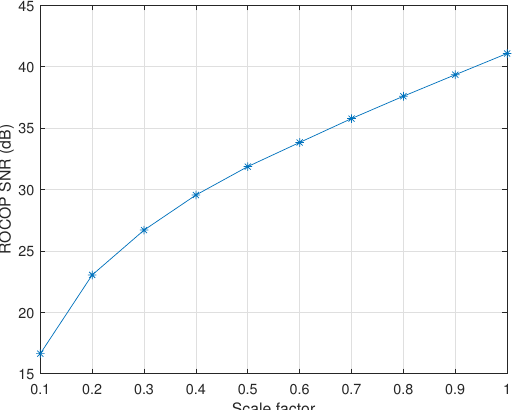
Figure 16. ROCOP SNR values versus the scaling factors for the considered arc event 11.